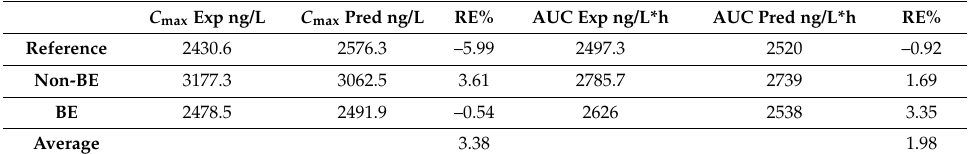
Table 5. Experimental and predicted plasma C max and area under the curve (AUC) values for all DKT formulations and relative prediction errors.